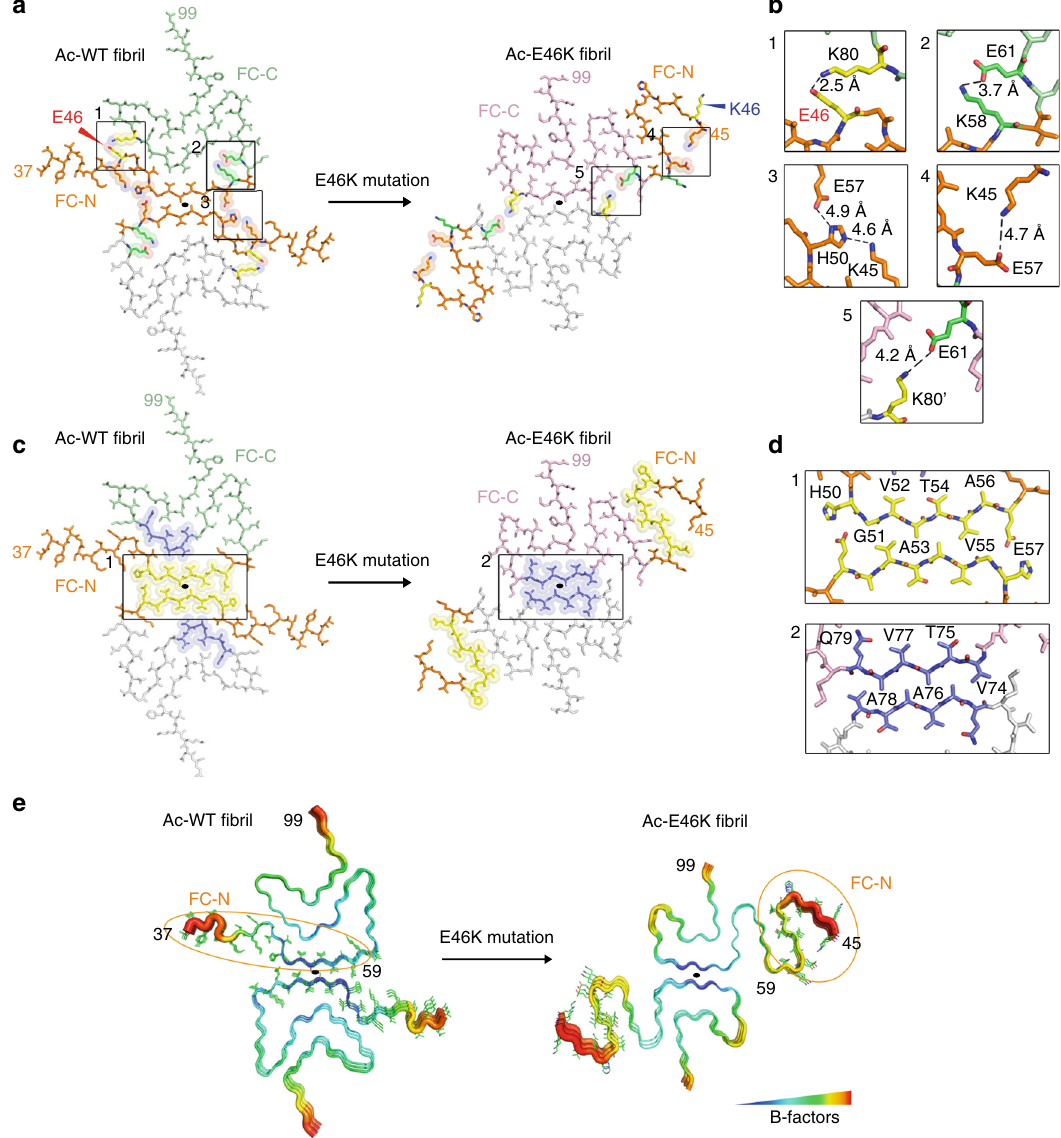
Fig. 4 Rearrangement of the α -syn fi bril structure triggered by E46K mutation. a Electrostatic interactions in the Ac-WT and Ac-E46K fi brils. K/E pairs that form salt bridges are highlighted with spheres and shown in zoom-in views in ( b ). The FC-N region (residues 37/45 – 59) is colored in orange. The mutation site E46/K46 is highlighted in red/blue. The black solid ellipses in all panels indicate the symmetric axis of the dimeric α -syn structure. b Zoom-in views of the corresponding regions in ( a ). Distances of the electrostatic interactions are indicated, and involved residues are labeled. The mutation site E46 is highlighted in red. c Proto fi lamental interfaces of the Ac-WT and Ac-E46K fi brils. Residues involved in the interfaces are highlighted with spheres. The fi bril interface of Ac-WT fi bril is colored in yellow; that of the Ac-E46K fi bril is in blue. The interfaces are zoomed in ( d ). d Zoom-in views of the fi bril interfaces. Interface residues are labeled. e Conformational change of the FC-N region results in a decreased stability of this region. Three layers of the α - syn fi brils are shown in B-factor putty. The FC-N region is shown in lines and highlighted with orange